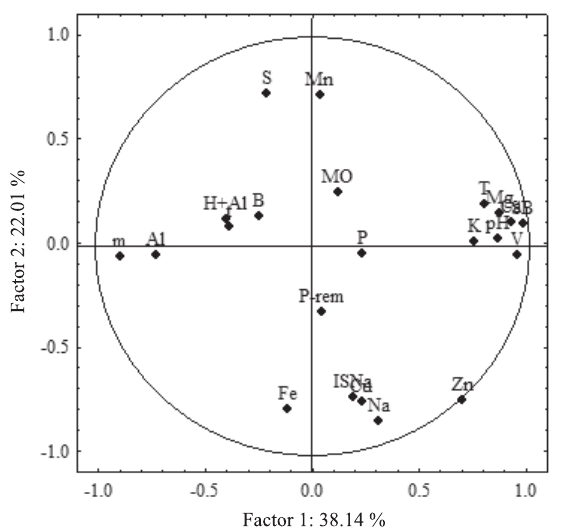
figure 2. circle of correlation of the plane formed by principal components 1 and 2 with the ori- ginal